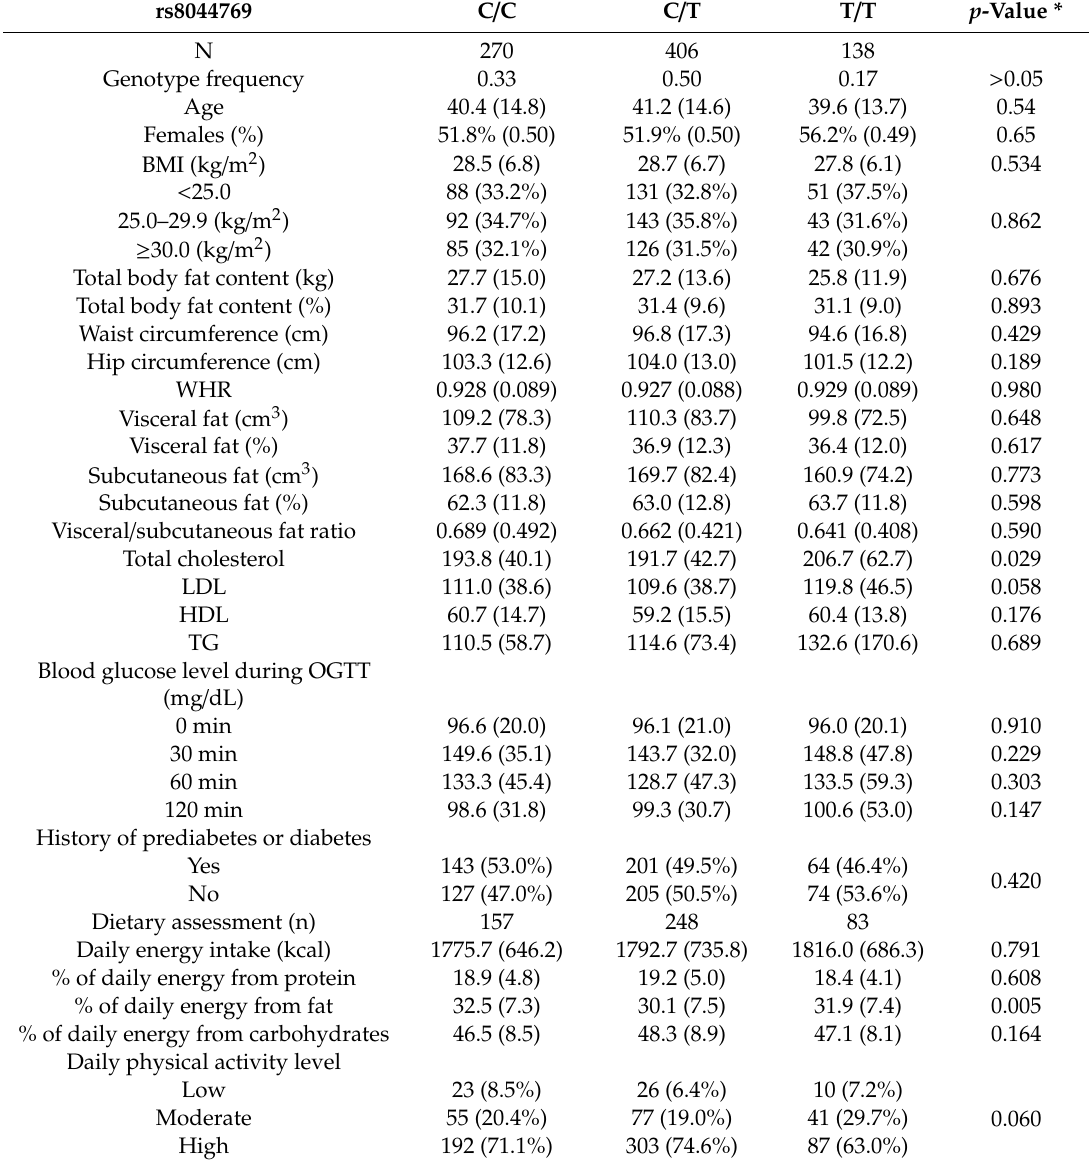
Table 4. Characteristics of participants stratified by rs8044769